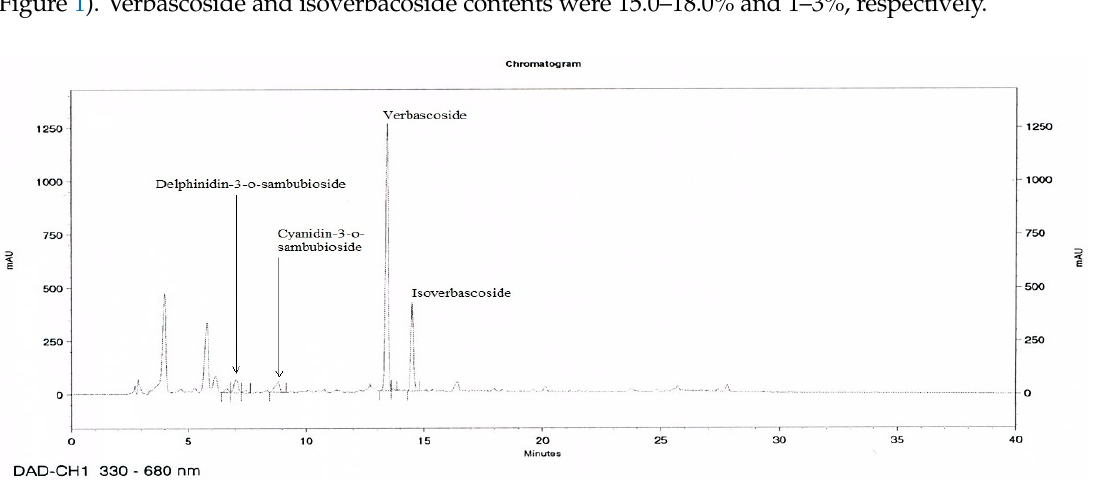
Figure 1. Representative high-performance liquid chromatography (HPLC) chromatograms of the Metabolaid ® (MetA). HPLC chromatograms of two extract mixtures at 320 and 520 nm. Delphinidin-3-o-sambubioside, cyanidin-3-o-sambubioside, verbascoside, and isoverbascoside appeared at retention times of 7.1, 8.8, 13.4, and 14.5 min, respectively.